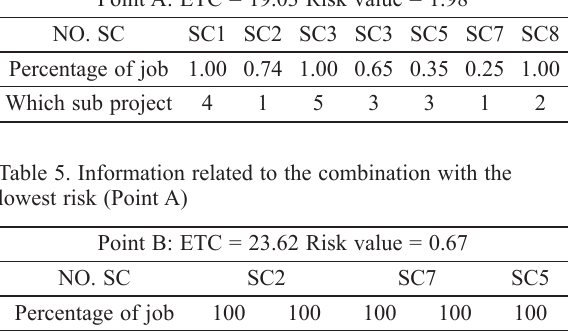
Fig. 4. The SPST outputs Table 4. Information related to the combination with the lowest cost (Point B) Point A: ETC = 19.03 Risk value = 1.98